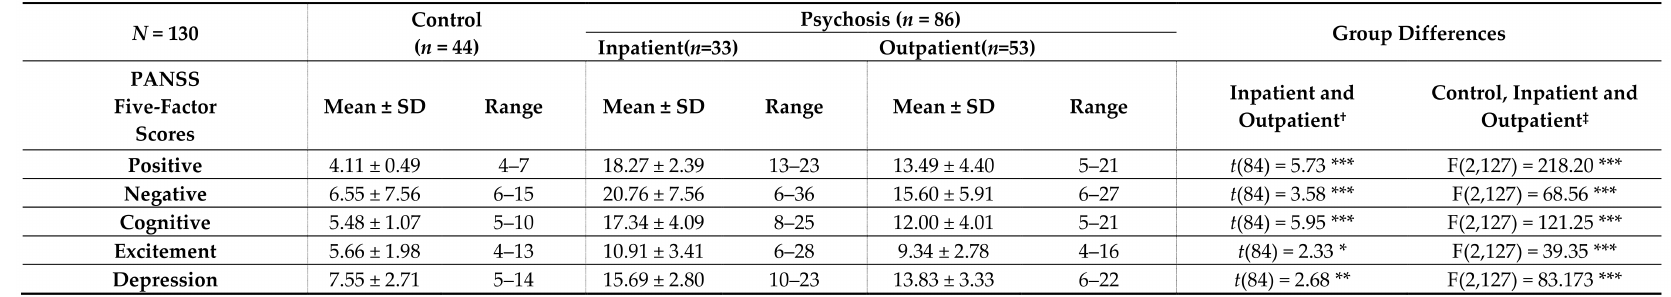
Table 2. Participant clinical characteristics using PANSS five factor